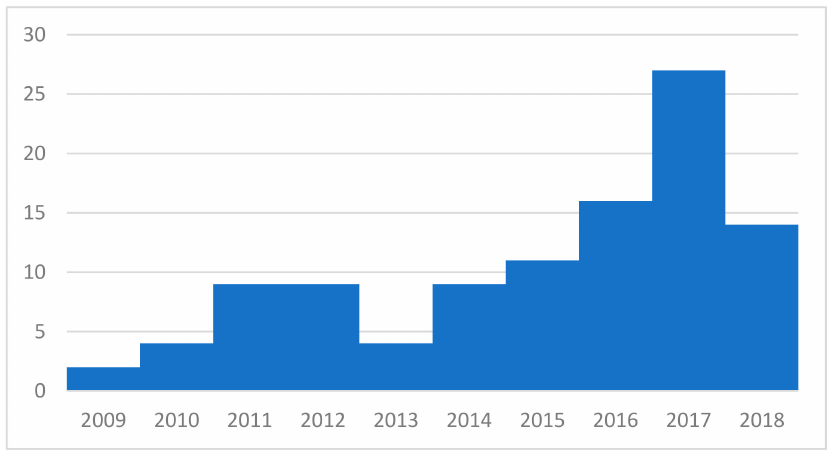
Figure 1. Distribution of Reviewed Articles by Year of